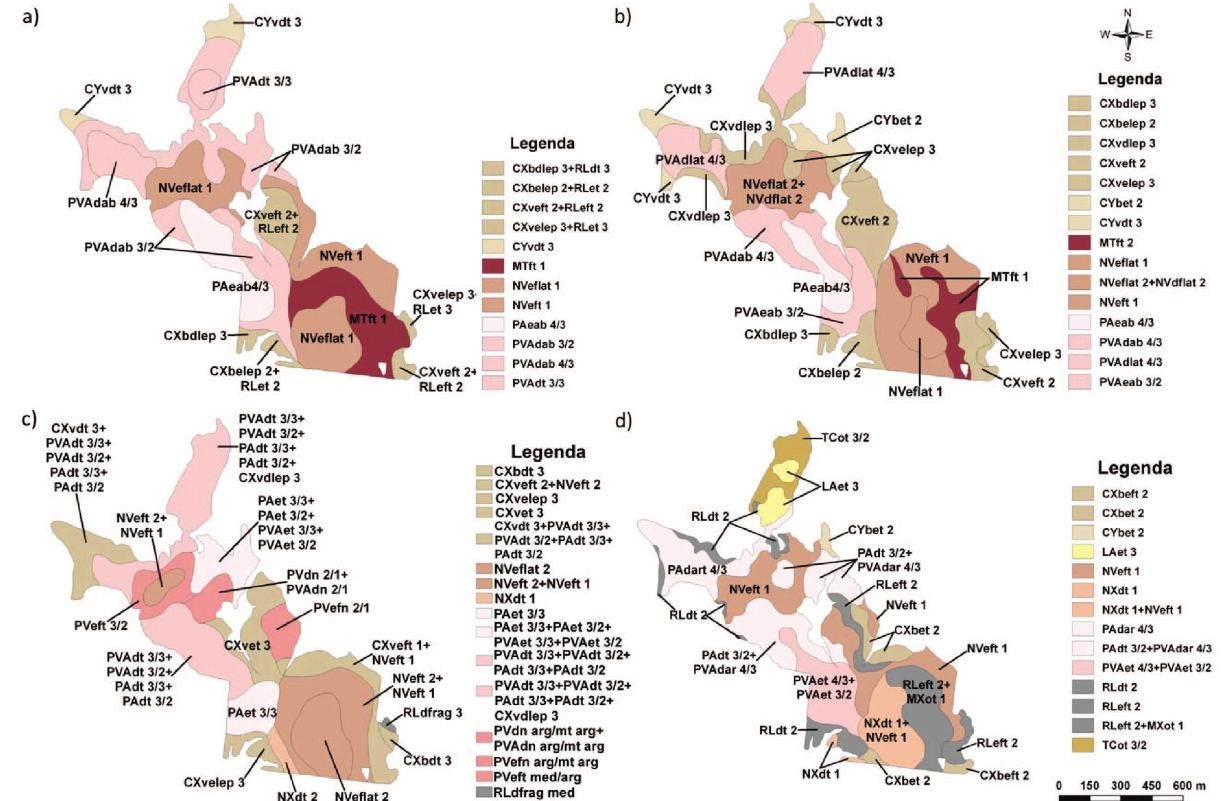
Figure 2. Conventional soil maps: a) map A; b) map B; c) map C, and d) map